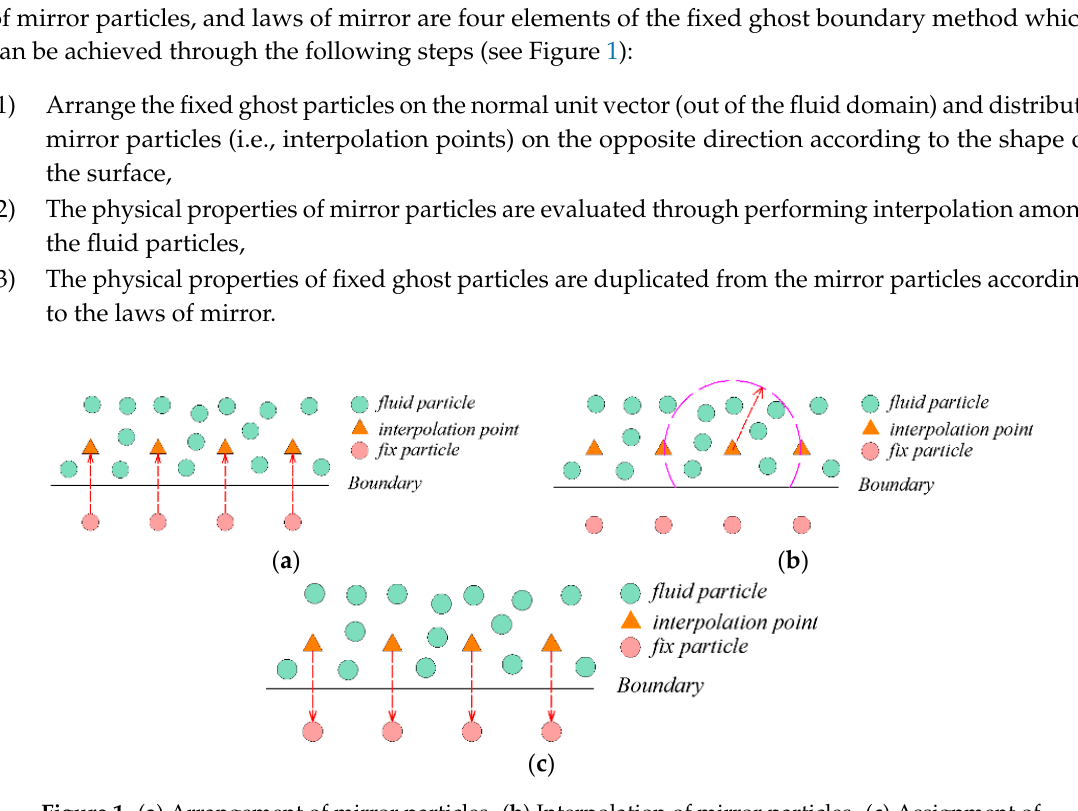
Figure 1. ( a ) Arrangement of mirror particles. ( b ) Interpolation of mirror particles. ( c ) Assignment of fixed particles.